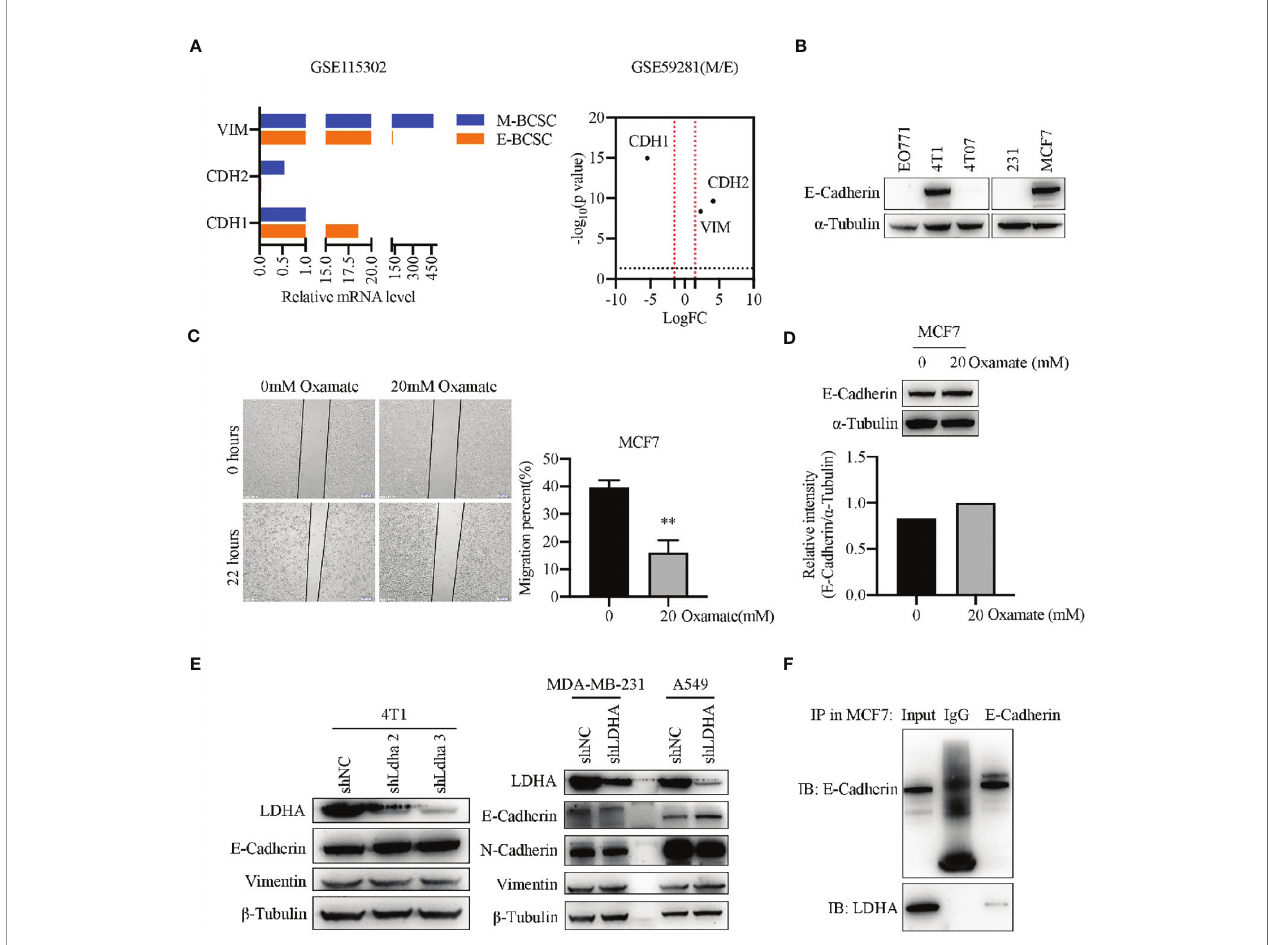
FIGURE 4 | Epithelial marker E-cadherin was negatively regulated by LDHA. (A) Transcripts of CDH1, CDH2, and VIM were analyzed in E-BCSCs or M-BCSCs population based on GSE115302 and GSE59281 data sets. The horizontal dotted line represents P = 0.05, the vertical dotted line represents logFC = 2/ − 2. (B) Western blot analysis for E-Cadherin in EO771, 4T1, 4T07, MDA-MB-231 and MCF7 cells. (C) Cellular migration was measured by wound healing assay in MCF7 cells treated with 0 or 20 mM oxamate for 30 h. Scale bar, 200 m m (insets). (D) Western blot analysis for E-Cadherin in MCF7 cells treated with 0 or 20 mM oxamate for 30 h. (E) Western blot analysis for LDHA, E-Cadherin, N-Cadherin and Vimentin in A549-shLDHA or MDA-MB-231-shLDHA cancer cells. (F) Immunoprecipitation analysis of the interaction between LDHA and E-Cadherin in MCF7 cells. ** P <